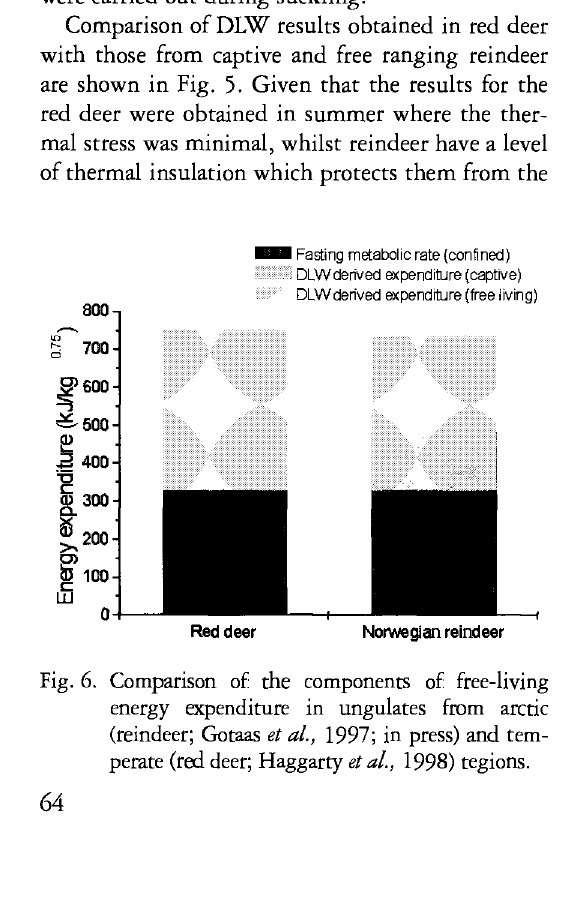
Fig. 6. Comparison of the components of free-living energy expenditure in ungulates from arctic (reindeer; Gotaas et al., 1997; in press) and tem perate (red deer; Haggarty et al, 1998) 64